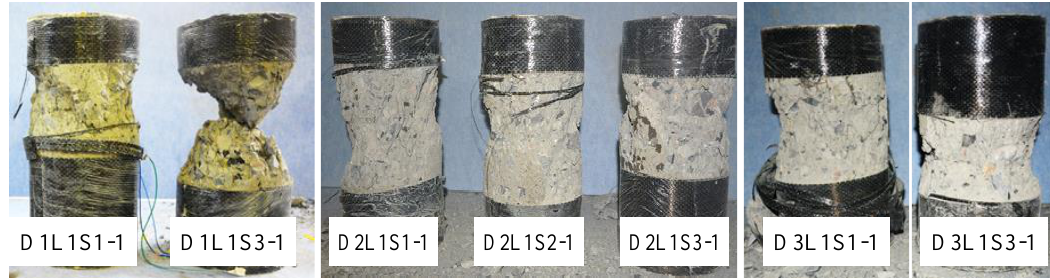
Figure 5. Typical failure of specimens.